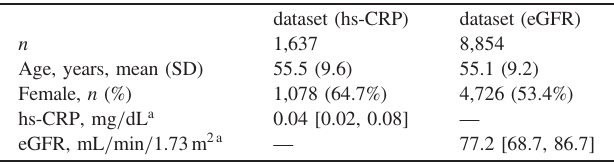
Table 1. Demographic characteristics of participants in the hs- CRP and the eGFR